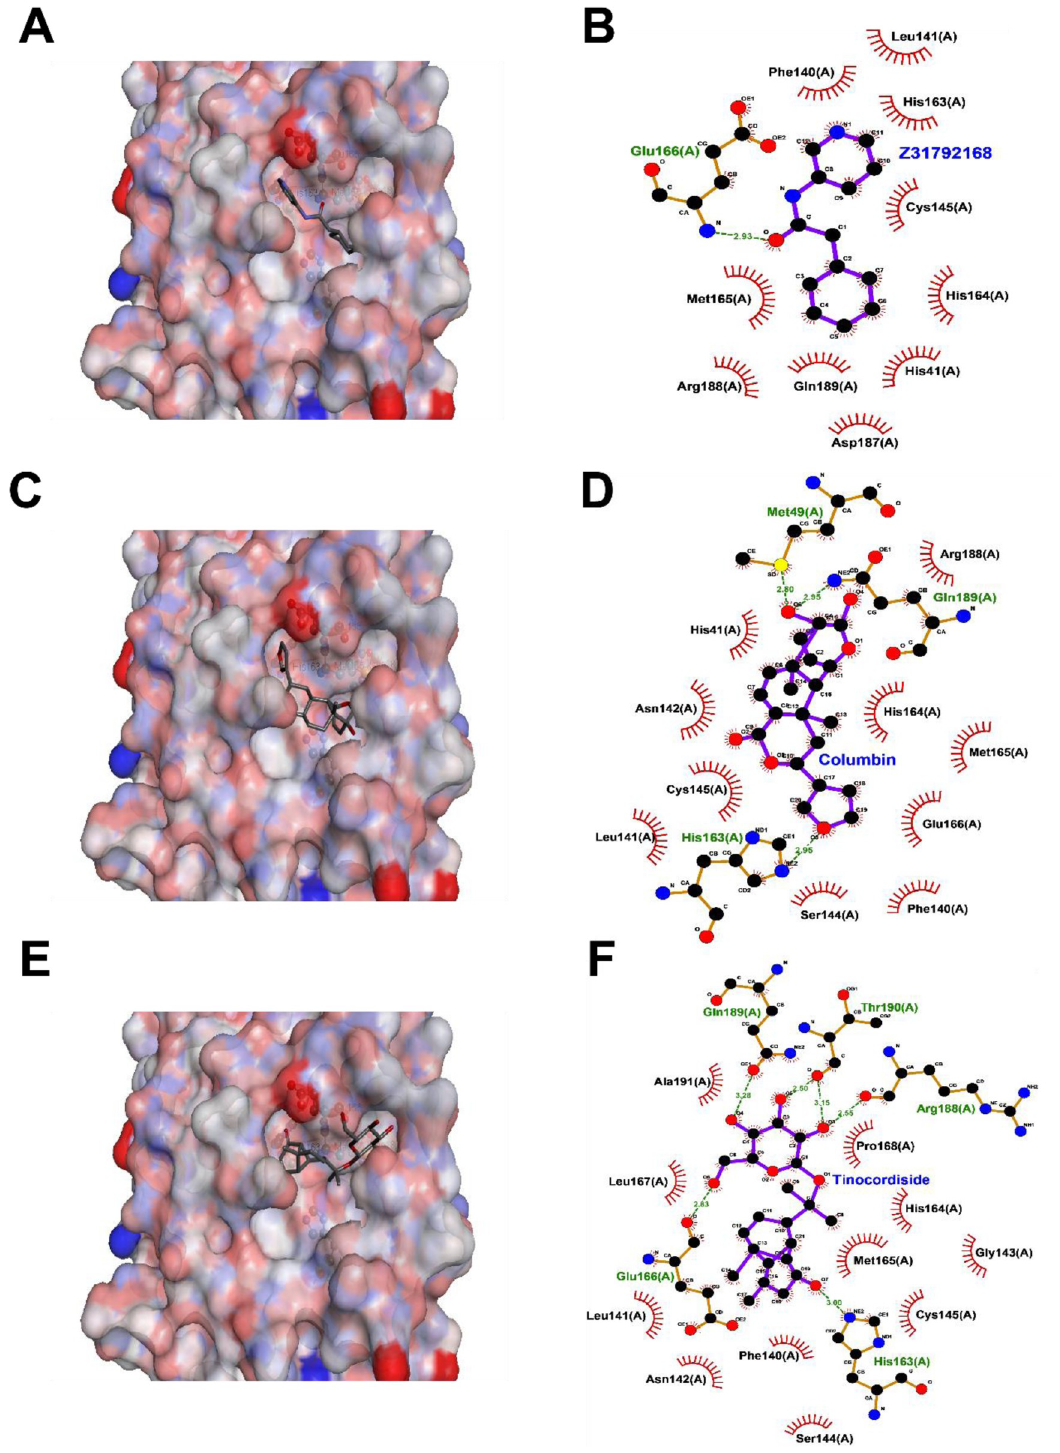
Fig 12. Interaction of (A and B) cyclohexyl-N-(3-pyridyl)acetamide (Z31792168), (C and D) Columbin and (E and F) Tinocordiside with M pro : In the left panel the protein is shown in a surface representation colored by atom while the ligand is shown in stick representation. The right panel is a 2D interaction plot of the receptor with the